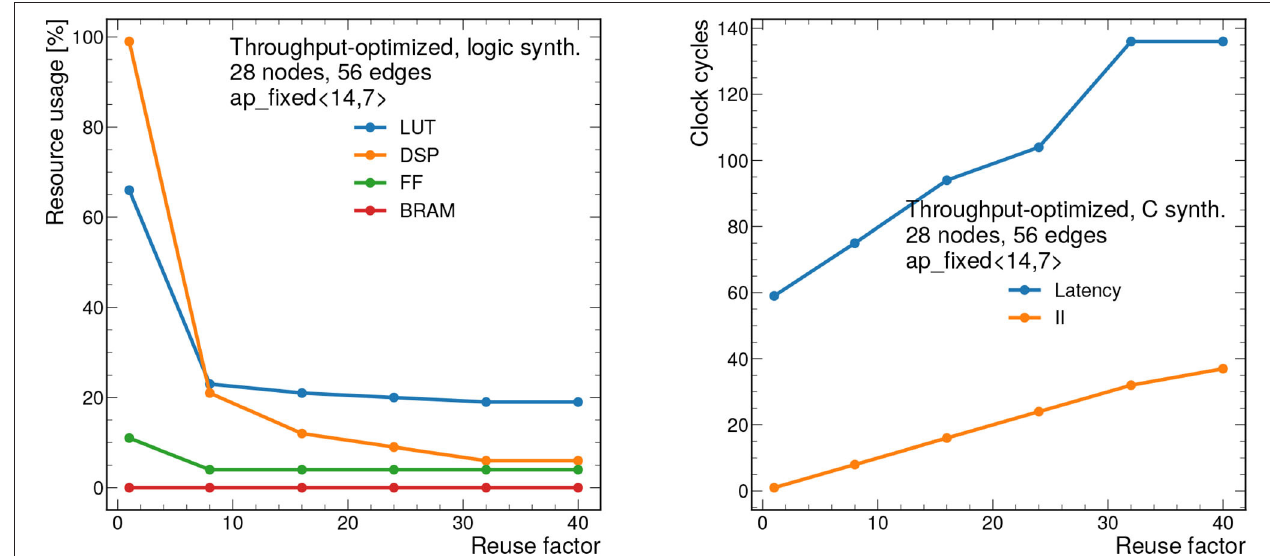
FIGURE 9 | Resource usage estimates as a percentage after logic synthesis (left) and latency and II in clock cycles (right) for a constant fixed point precision of ap_fixed<14,7> as a function of the reuse